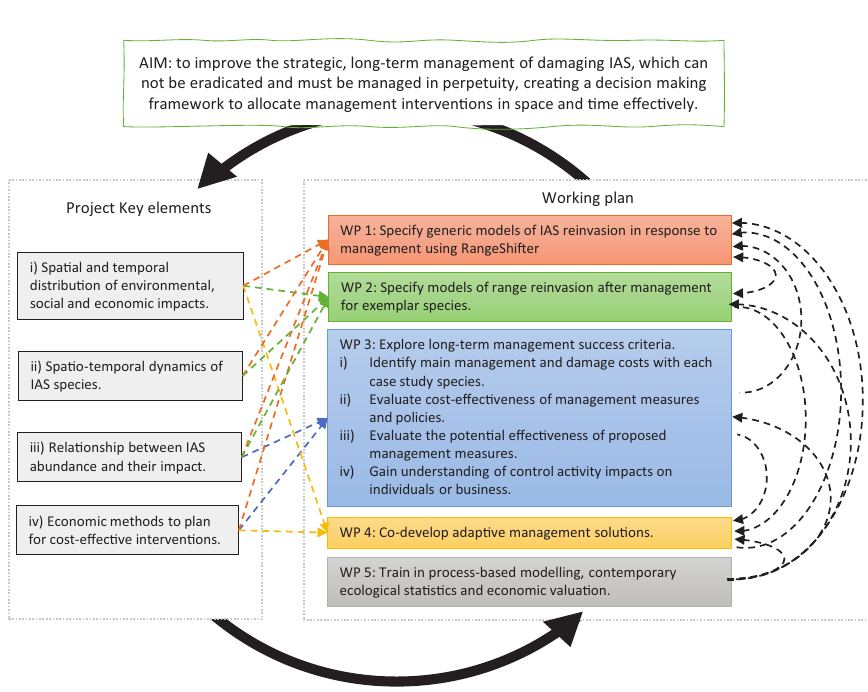
Figure 1. Diagram describing links between different Work packages (WPs) of CONTAIN. IAS refer to Invasive Alien